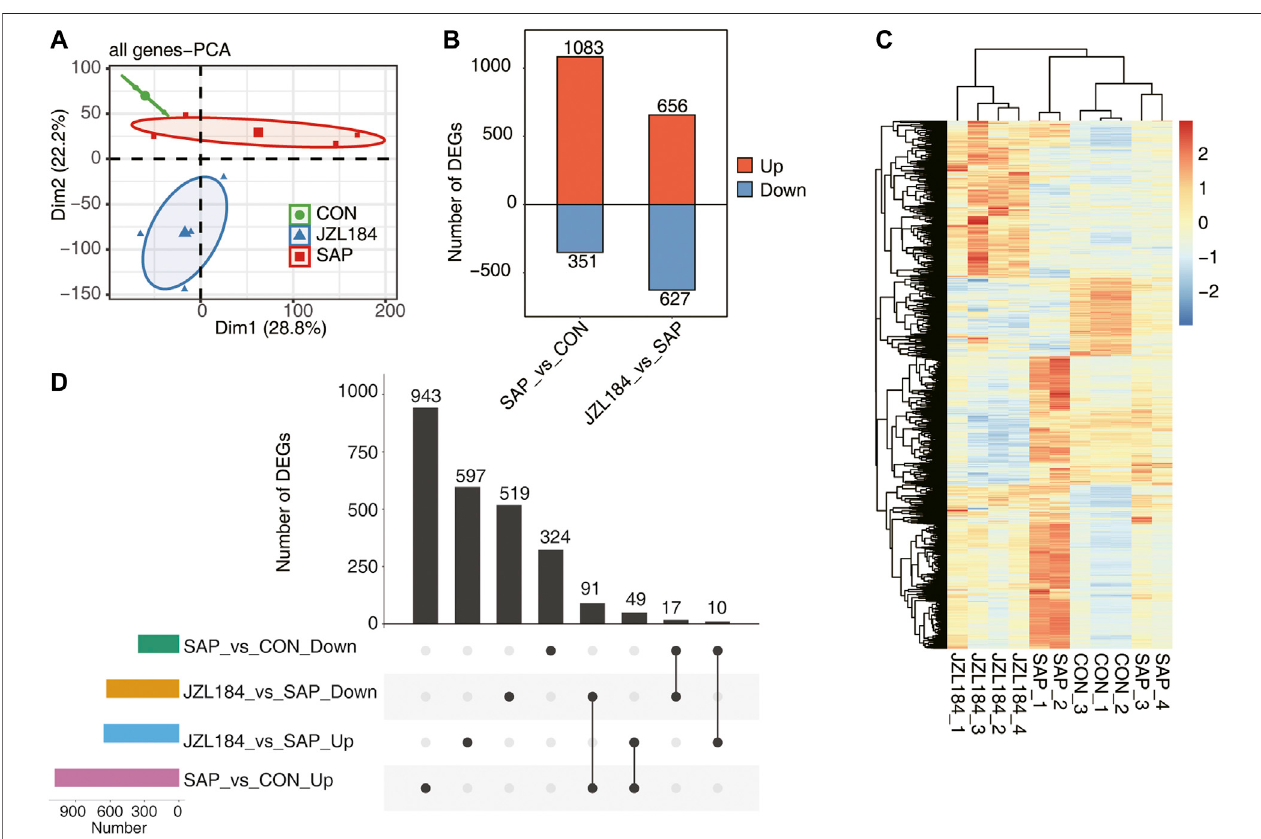
FIGURE 2| MAGLinhibitorbroadlyaffectthegeneexpressionpro fi leofintestinaltissueofratswithSAP. (A) PCAbaseonFPKMvalueofalldetectedgenes.Theellipsefor eachgroupisthecon fi denceellipse.Thecon fi denceellipsisofthethreegroupsdidnotoverlapandthesampleswereobviouslyseparated; (B) Barplotshowingtheresultofup- regulated and downregulated genes in the group comparisons. DEG analysis showed that 1,434 genes were differentially expressed between SAP and control groups; (C) Hierarchical clustering heat map showing expression levels of all DEGs. The expression of DEGs in SAP group showed slight differences due to individual responses to experimentaltreatments; (D) OverlapanalysisplotsofDEGsgenesineachgroup.Atotalof91DEGsweredownregulatedintheJZL184groupcomparedwiththeSAPgroup,but were upregulated in the SAP group compared with the control group. n = 3 in control group. n = 4 in SAP group and JZL184 group.